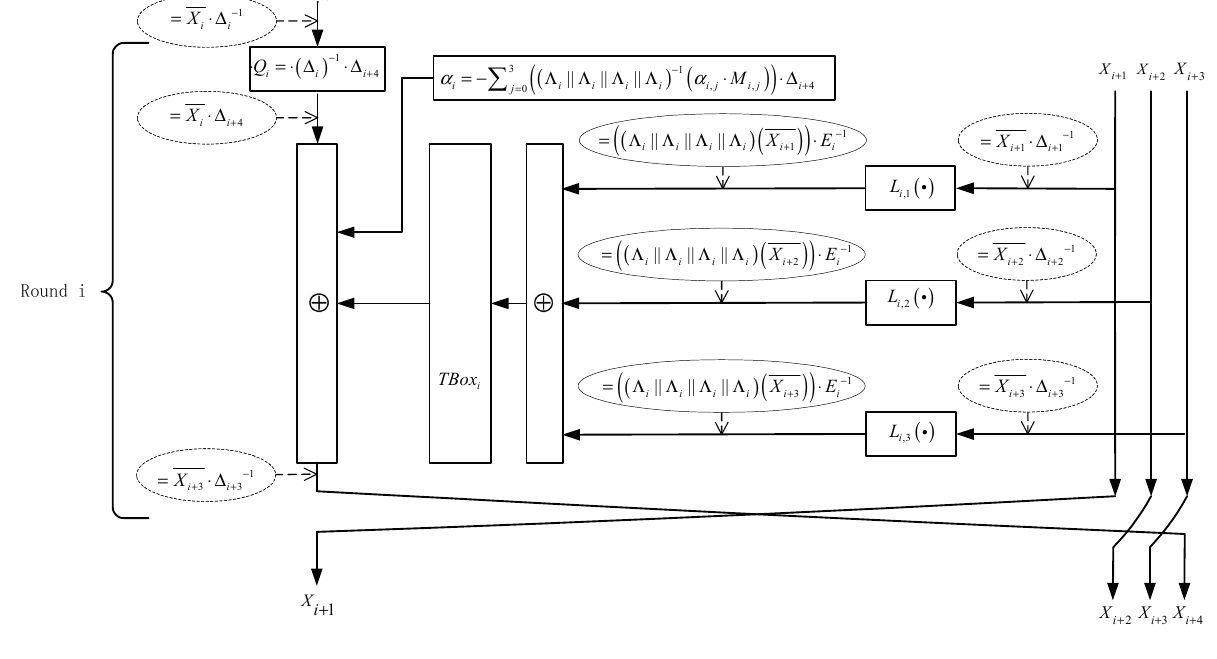
Figure 10. Non-standard states in the process of a white-box